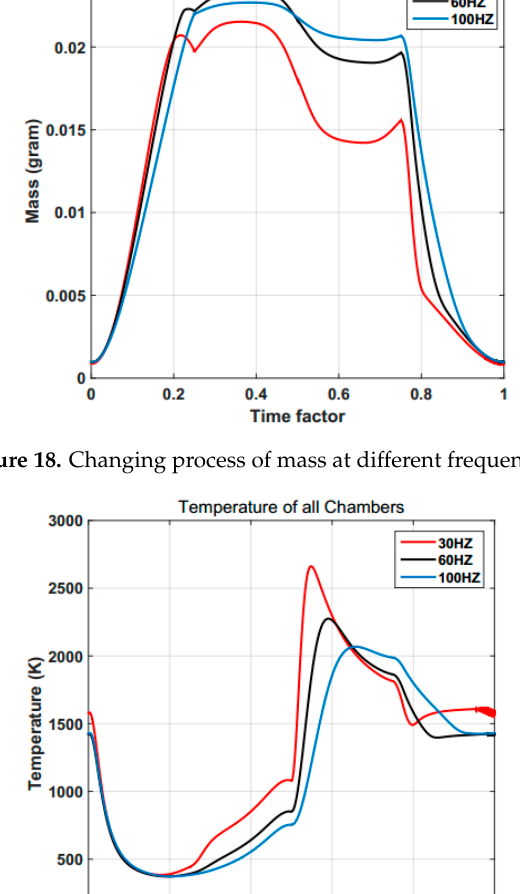
Figure 20. Thermal performances of MSRE at different frequencies. The overall engine performance at a series of operating frequencies is shown in Figure 20. Results show that the MSRE cannot function properly when the operating frequency was lower than 10 Hz, because both the engine efficiency and power are negative. For frequencies larger than 10 Hz, the maximum efficiency and power individually corresponded to an optimal frequency value. The reason is given as follows. As the working frequency increased from 10 Hz, although the leakage mass flow nearly remains the same, the available time for leakage was reduced, resulting in a weakened leakage effect, thereby improving the engine efficiency. In addition, the engine power increased accordingly, because the time ratio to output work per unit time increased. However, once the operating frequency grew excessively, the burn duration time could not be ignored, and the incomplete combustion could lead to more severe deterioration of the engine performance. As a consequence, two optimal values of frequency exist for engine performance and power. At an operating frequency of 55 Hz, the engine reached the optimum thermal efficiency (23.62%) with a power of 2458.18 W, which is approximately 4.72 times of the micro-turbine’s efficiency (5%). When the operating frequency is 95 Hz, it will reach the maximum power (3442 W) with a thermal efficiency of 18.96%. The corresponding power weight ratio is 1.72 kW/kg, about 5.21 times of that for the MICSE (0.33 kW/kg) and 3.44 times of that for conventional IC engines (0.5 kW/kg).